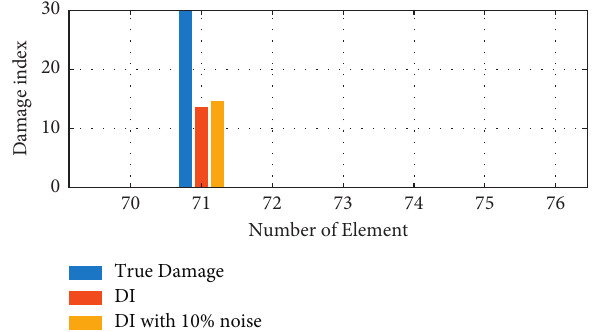
Figure 19: Results of damage scenario D1 containing 10% measurement noise using first 3 modes enlarged